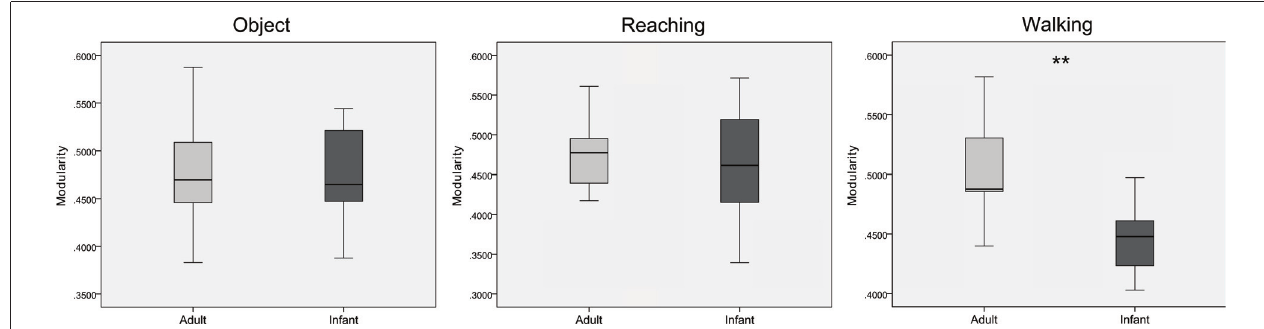
FIGURE 5 | Boxplots showing differences between infants and adults in mean values of modularity for the three conditions (from left to right: object, reaching, walking) . ** p < 0.01. Whiskers are representing minimum and maximum points of the